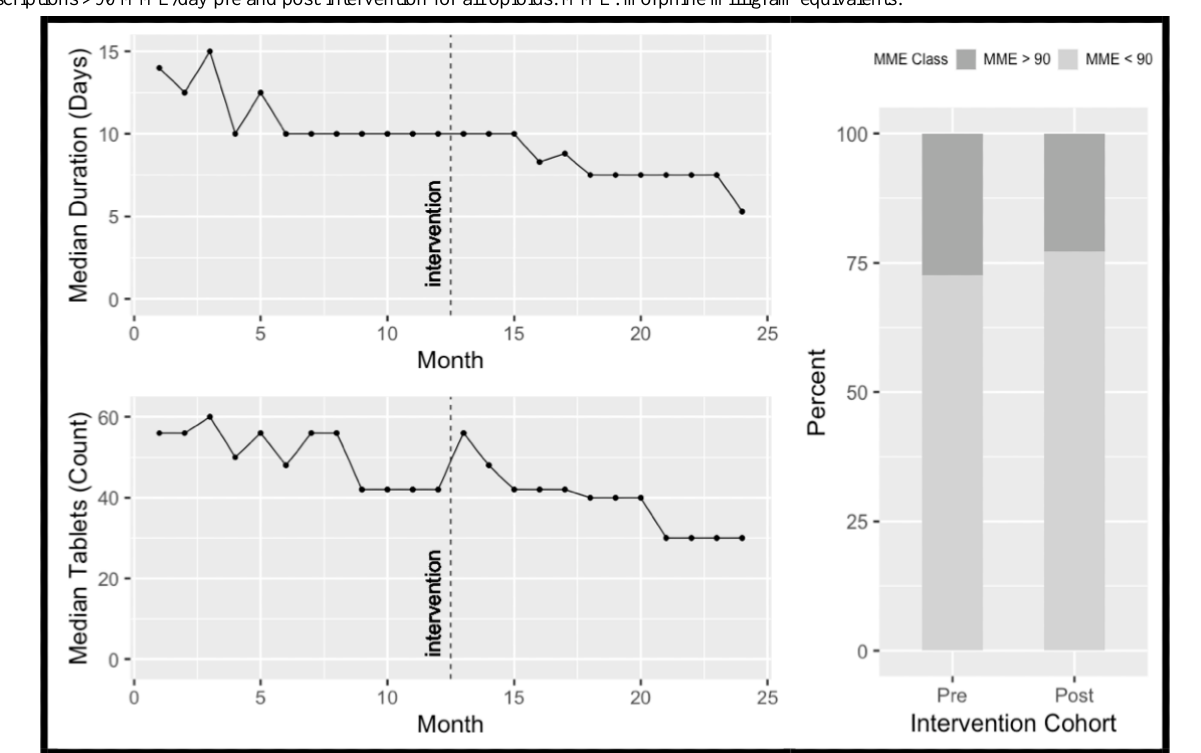
Figure 2. Monthly median tablets prescribed pre and post-intervention, monthly median duration (days) pre and post-intervention and proportion of prescriptions >90 MME/day pre and post-intervention for all opioids. MME: morphine milligram